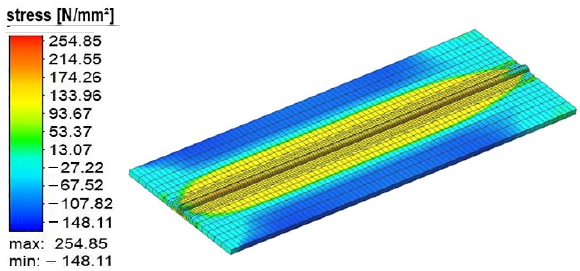
Figure 5. the welding induced residual stress. Figure 5. The welding induced residual stress.